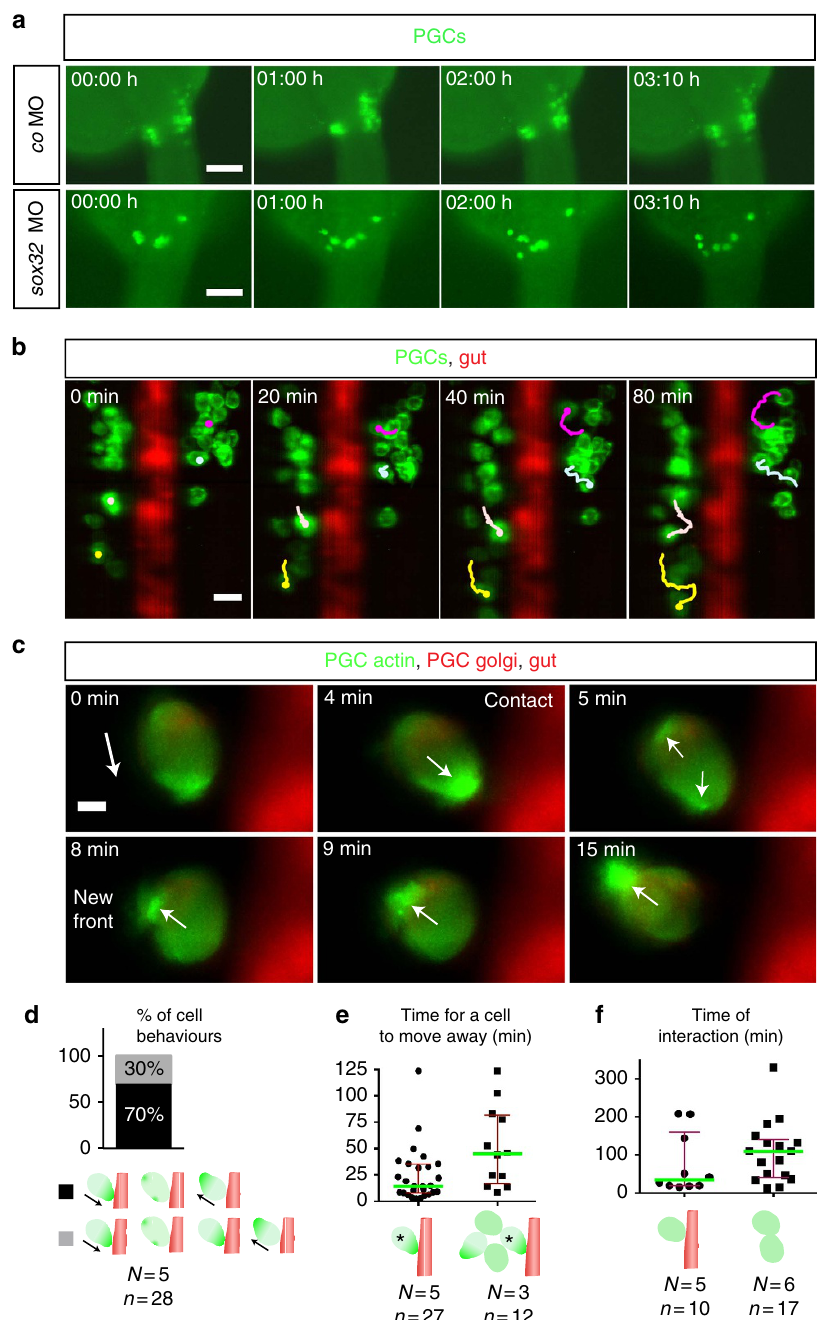
Figure 6 | The developing gut functions as a physical barrier. ( a ) PGCs exhibiting dynamic movements within separated clusters (control, upper), while in embryos lacking the gut (lower panels) PGCs migrate over the midline to form one cluster (Supplementary Movie 4). Time point 0 corresponds to 24.5hpf Scale bars, 100 m m. ( b ) Four representative migration tracks of PGCs relative to the gut (Supplementary Movie 5). PGC tracking using ImageJ. Scale bar, 25 m m. ( c ) Interaction of a PGC with the gut tube (Supplementary Movie 6). Polarity change in actin distribution is observed on contact. Time point 0 corresponds to 25hpf The white arrow displays the direction of actin polarity. Scale bar, 5 m m. ( d ) PGC behaviours. On touching the gut, the main behaviour observed (29/42 encounters for 28 PGCs) is a rapid (14min) polarity inversion away from the barrier and a change in the direction of migration. In the remaining encounters (13/42) PGCs exhibited a prolonged contact with the gut (69min) without stable polariziation. ( e ) Cell crowding prolongs the time required for moving away from the barrier (45 versus 14min; Mann–Whitney U -test, ** P r 0.01). ( f ) Increased interaction time among PGCs that do not touch (right), as compared with the interaction time large and small clusters of the PGCs with the barrier (left). ( d – f ) Error bars display interquartile range, green lines median values, N and n number of embryos and PGCs respectively. The PGCs are shown in green and the gut in red (gut not presented in the right schematic drawing in f where PGC–PGC interaction time is displayed).